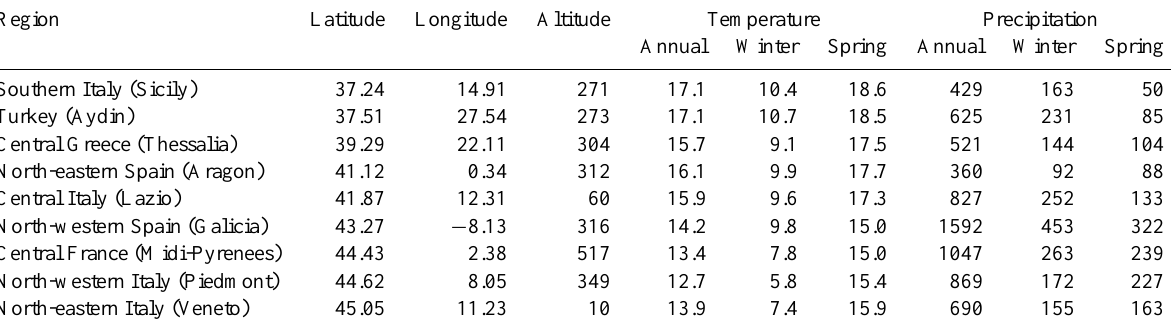
Table 1. Location of the nine grid points selected to perform the SIRIUS sensitivity analysis for producing the ANN training set and central values of annual, winter and spring temperatures ( ◦ C) and precipitation (mm) of the corresponding climate class.